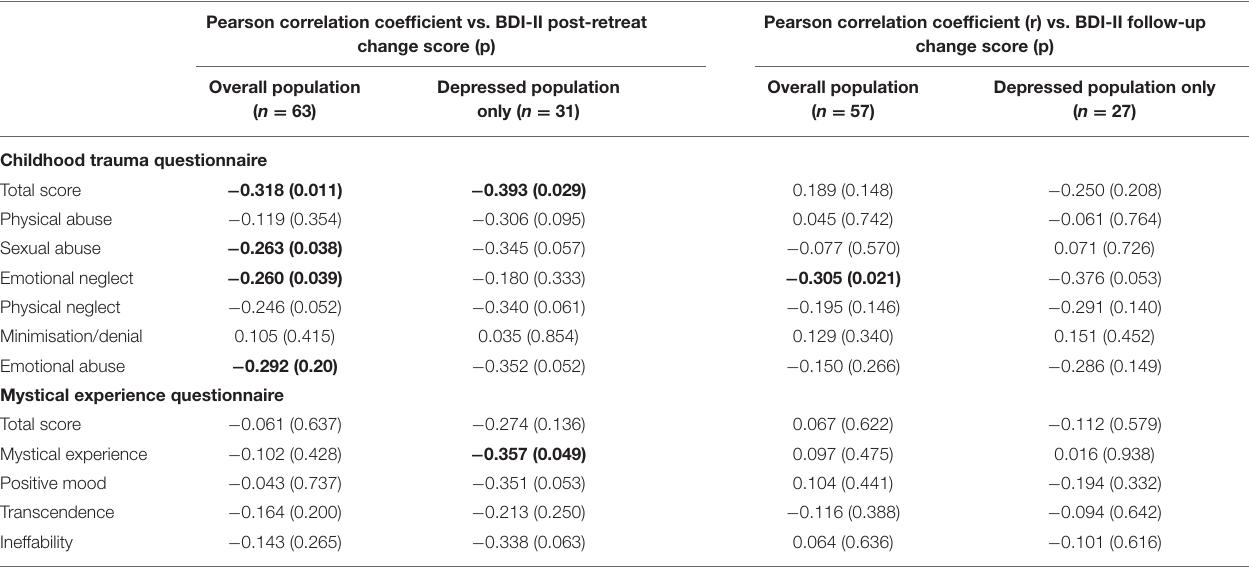
TABLE 4 | Correlation coefficients vs. BDI-II change scores at post-retreat and 6 month follow-up. Pearson correlation coefficient vs. BDI-II post-retreat change score (p) Overall population Depressed population ( n = 63) only ( n = 31)